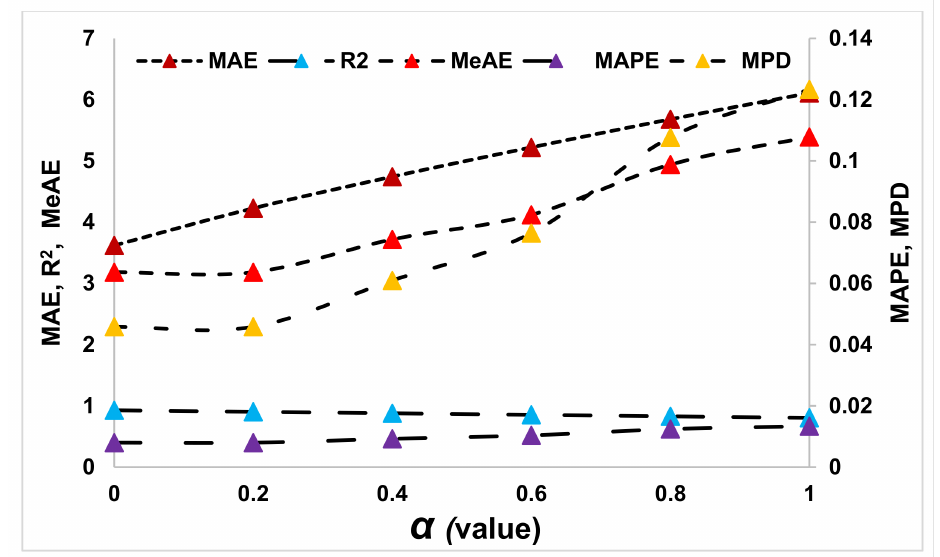
Figure 7. Performance of Ridge regressor at different α values from the training computations (R 2 is shown as R2 in the graph legends).